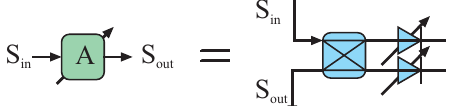
Figure 5. An automatic gain control (AGC) in the microwave domain can be formed by a low noise amplifier (LNA) followed by a variable